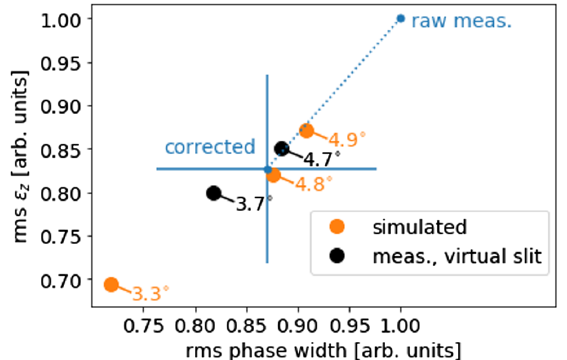
FIG. 10. Comparison of analytic error estimate with actual errors for simulated and measured emittance measurements. The scale is defined relative to the raw measurement value. The line shows the measured and corrected value for the phase space shown in Fig. 7 with 1 σ error bars on the corrected value. The scatter points show the relative values of the “ true ” emittance and phase widths, as determined from the virtual slit measurement and simulated emittance reconstruction.